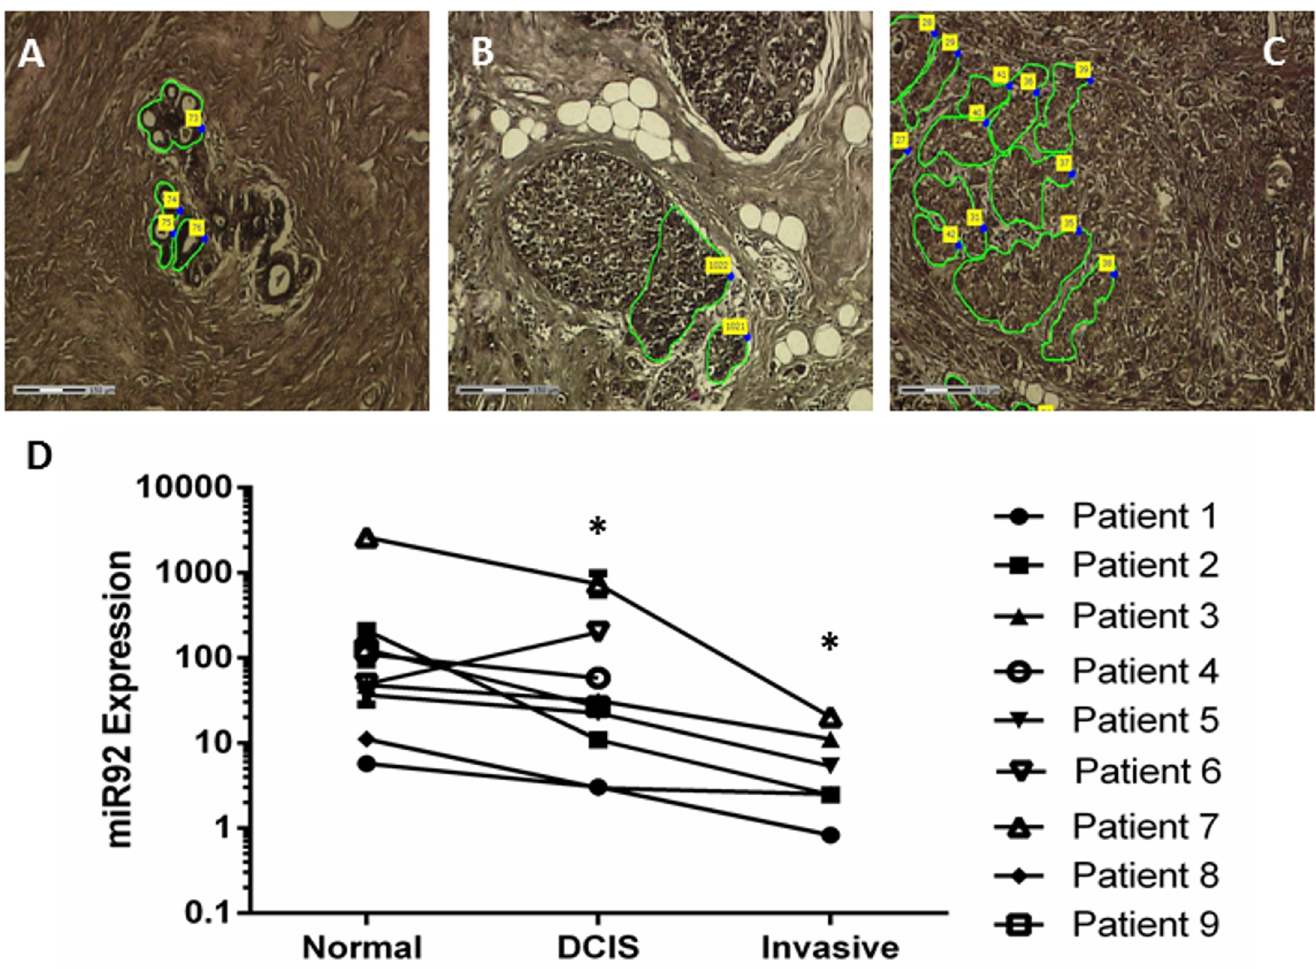
Fig 2. Laser micro-dissection (LMD) was used to isolate areas of epithelium in normal (A), DCIS (B) and invasive (C) breast tissue from the same tissue section. Breast tissue images show examples of the areas captured for patient 4 as a representative example. The expression of miR – 92 decreased during breast cancer progression with highest levels observed in normal breast epithelium, decreasing in DCIS and being lowest in invasive breast tissue (D). * denotes significance of p <